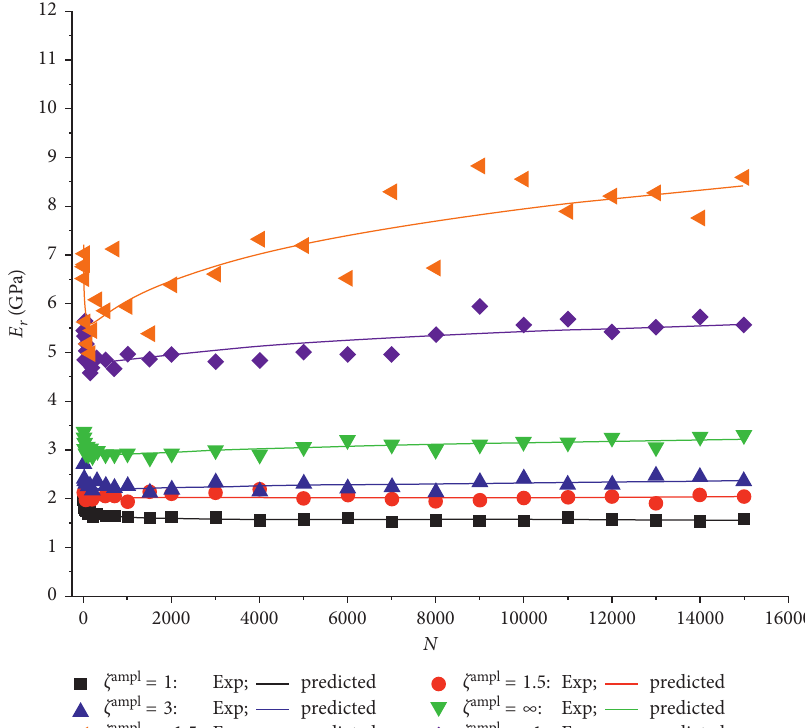
Figure 8: Relationship between resilient modulus and the number of load cycles under different ζ ampl